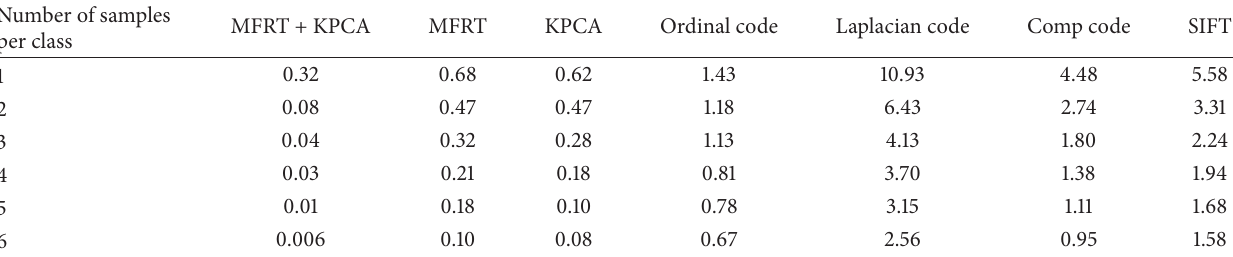
Table 8: Equal error rate accuracy measures from Poly U palm print